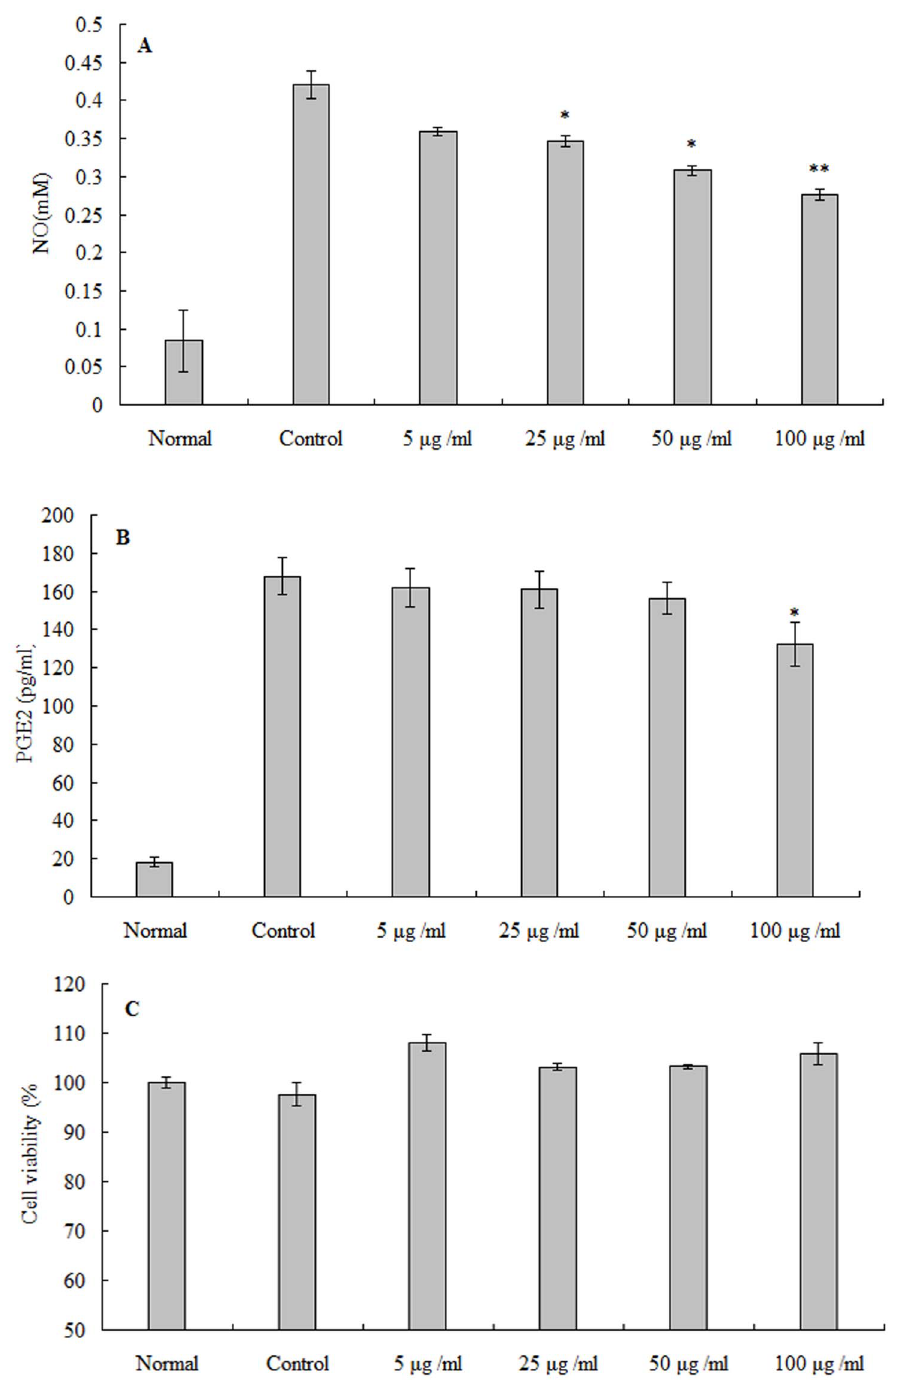
Fig. 3. The effect of MEO on NO and PGE2 production of LPS-stimulated RAW 264.7 macrophage cells. (A) represents the inhibitory effect of NO production, (B) represents the inhibitory effect of MEO on PGE2 production; and (C) indicates the cytotoxic effect of MEO on RAW 264.7 cells. Results are mean ¡ SD (n 5 3).